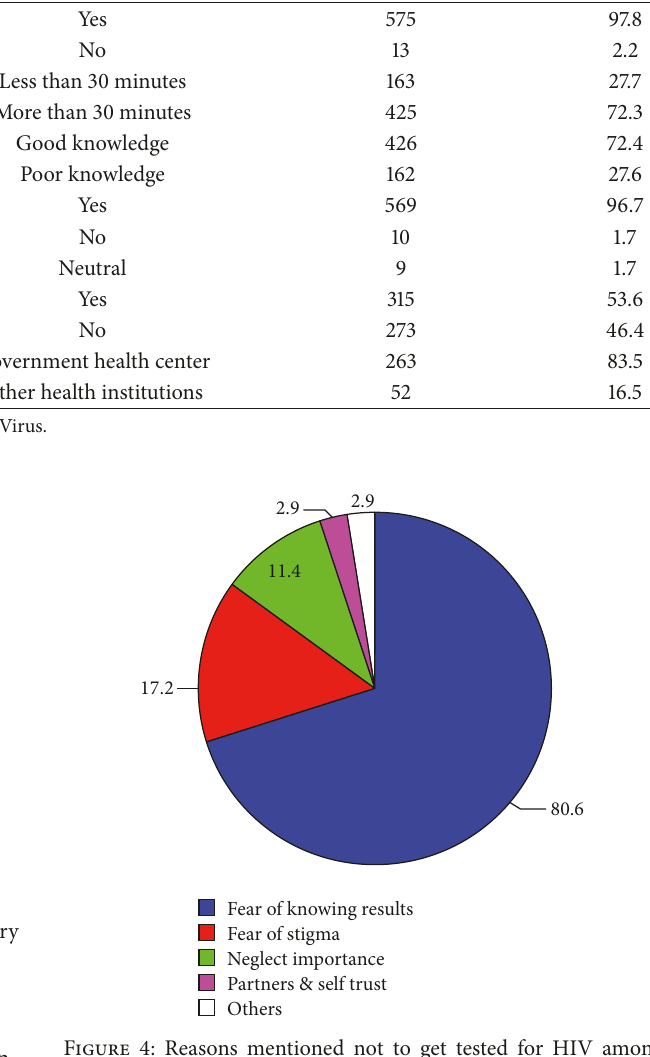
Figure 4: Reasons mentioned not to get tested for HIV among secondary school teachers in Awi Zone, Amhara Region, 2014.